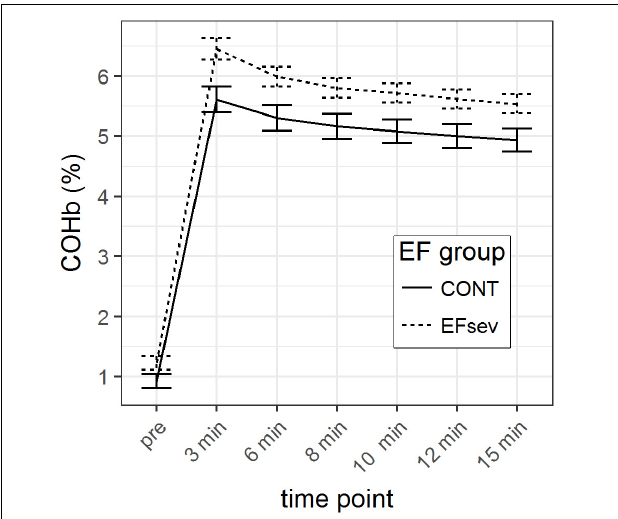
FIGURE 1 | Course of carboxyhemoglobin (COHb) in capillary blood before and after rebreathing of carbon monoxide (CO) for 2 min using the optimized CO rebreathing method (oCORM). Data is displayed during a period of 15 min. Groups: CONT, control subjects; EFsev, subjects with EF < 30%.